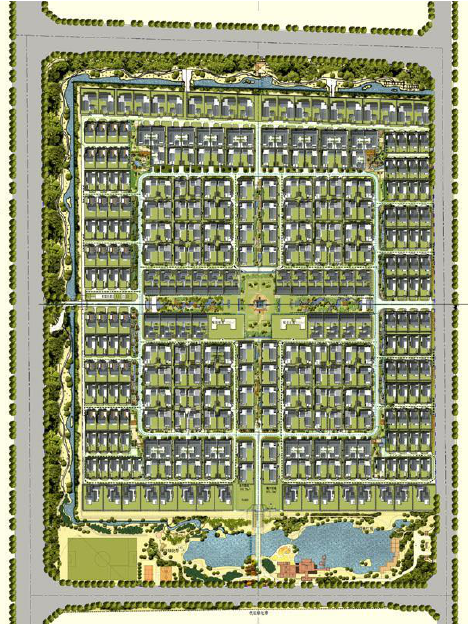
Figure 7. Site plan of Beijing Guantang (“Cathay View Villa Estate,” b. 2005-2008). Source: Architectural Design 2014.